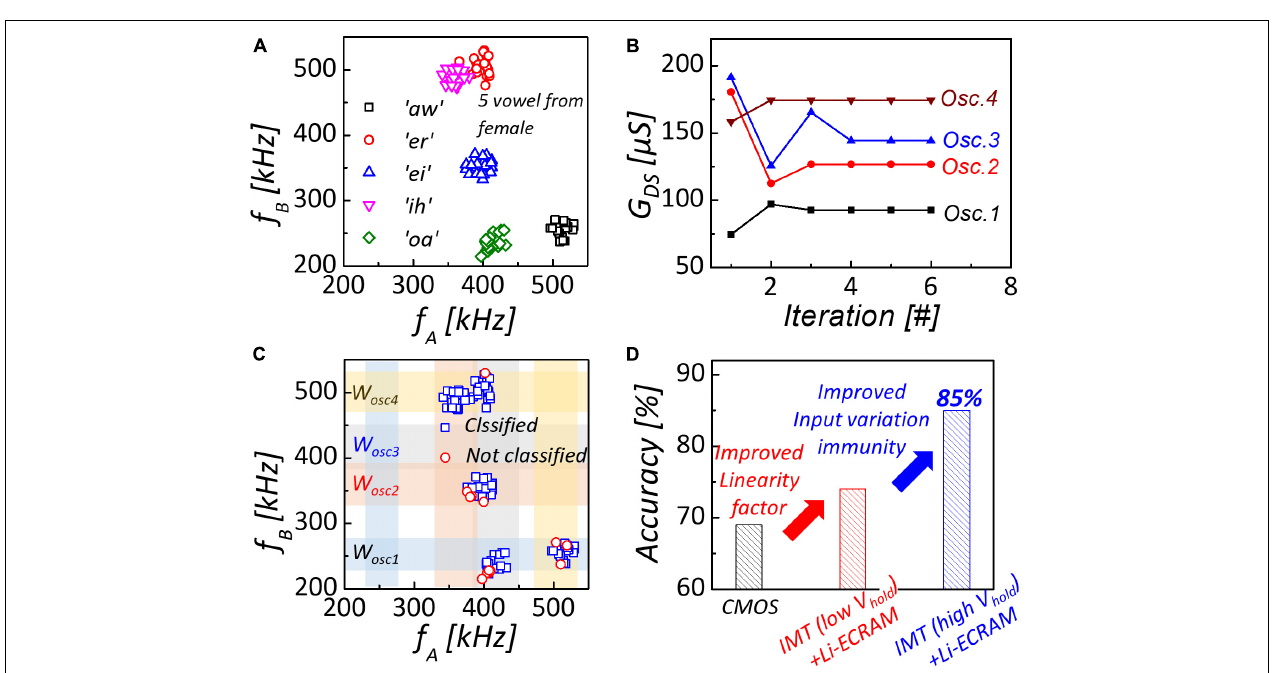
FIGURE 5 | (A) Dataset of spoken vowel. Formant frequencies of spoken vowel is processed by linear transformation to match frequency of NbO 2 -based oscillator with Li-ECRAM. (B) Conductance of Li-ECRAMs as function of training iteration. After five iterations, channel conductance of Li-ECRAMs converge to the optimal value. (C) Synchronization map after training. Most of clustered data are covered by classifiable region. (D) Introducing Li-ECRAM and adjusting Vhold of NbO 2 , 85% classification accuracy can be